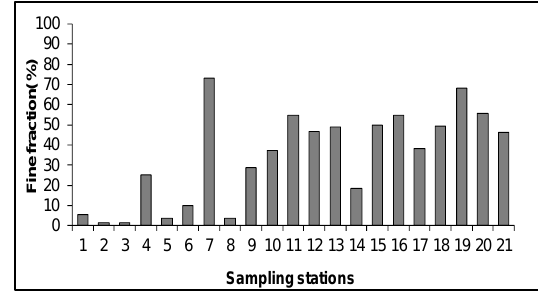
Figure 3 . Spatial distribution of fine fraction